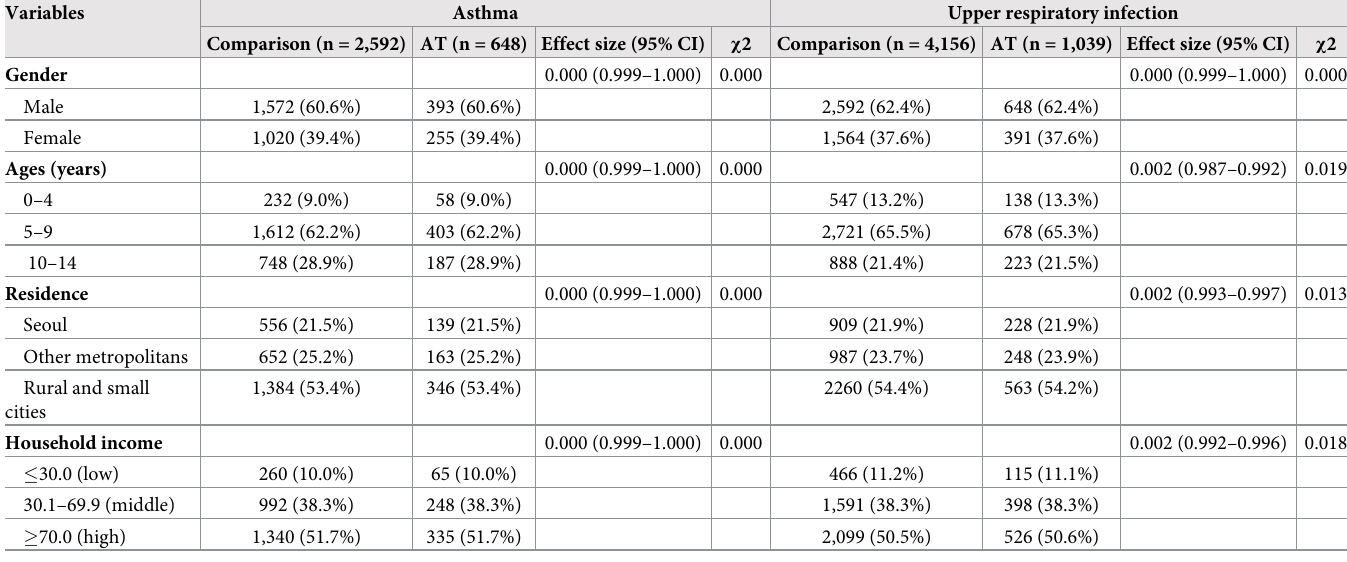
Table 1. Characteristics of the study